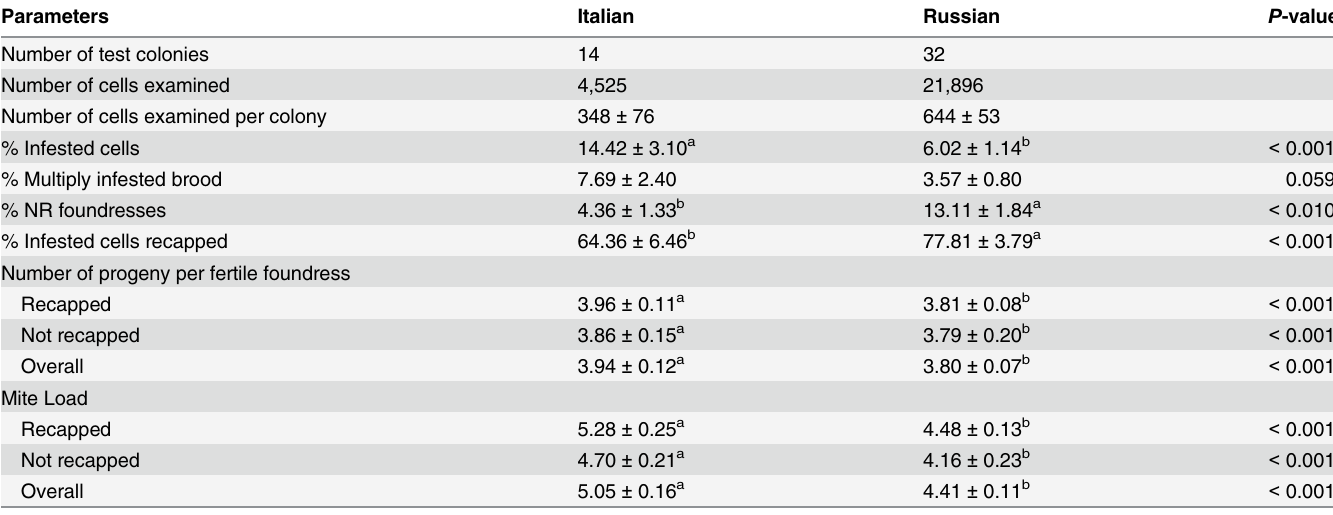
Table 2. Sample sizes, means ( ± SE) of different infestation parameters in resident brood of Italian and Russian honey bee colonies, and results of the student ’ s t-tests.